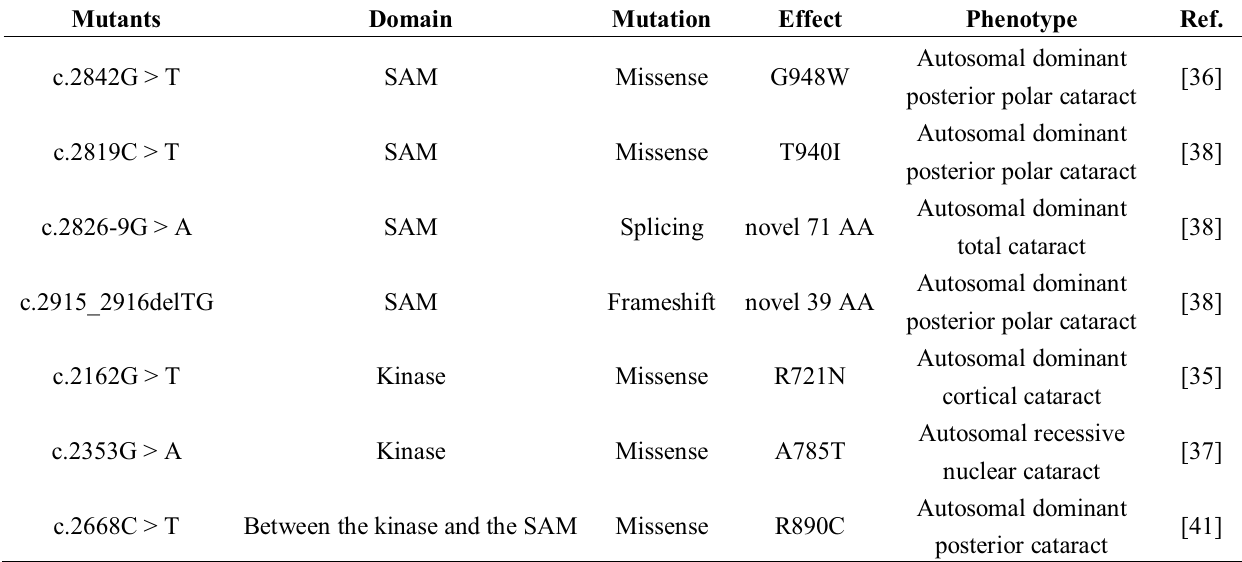
Table 1. EPHA2 mutations in